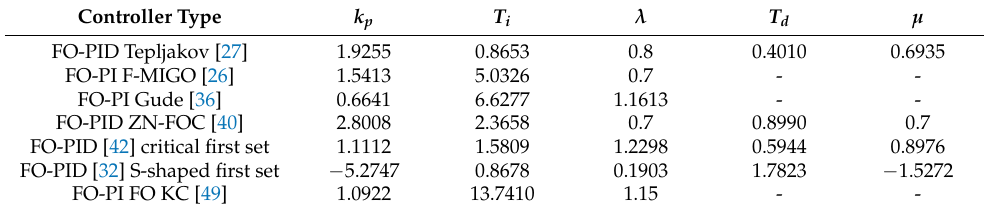
Table 2. FO-PID parameters computed for the lag-dominant